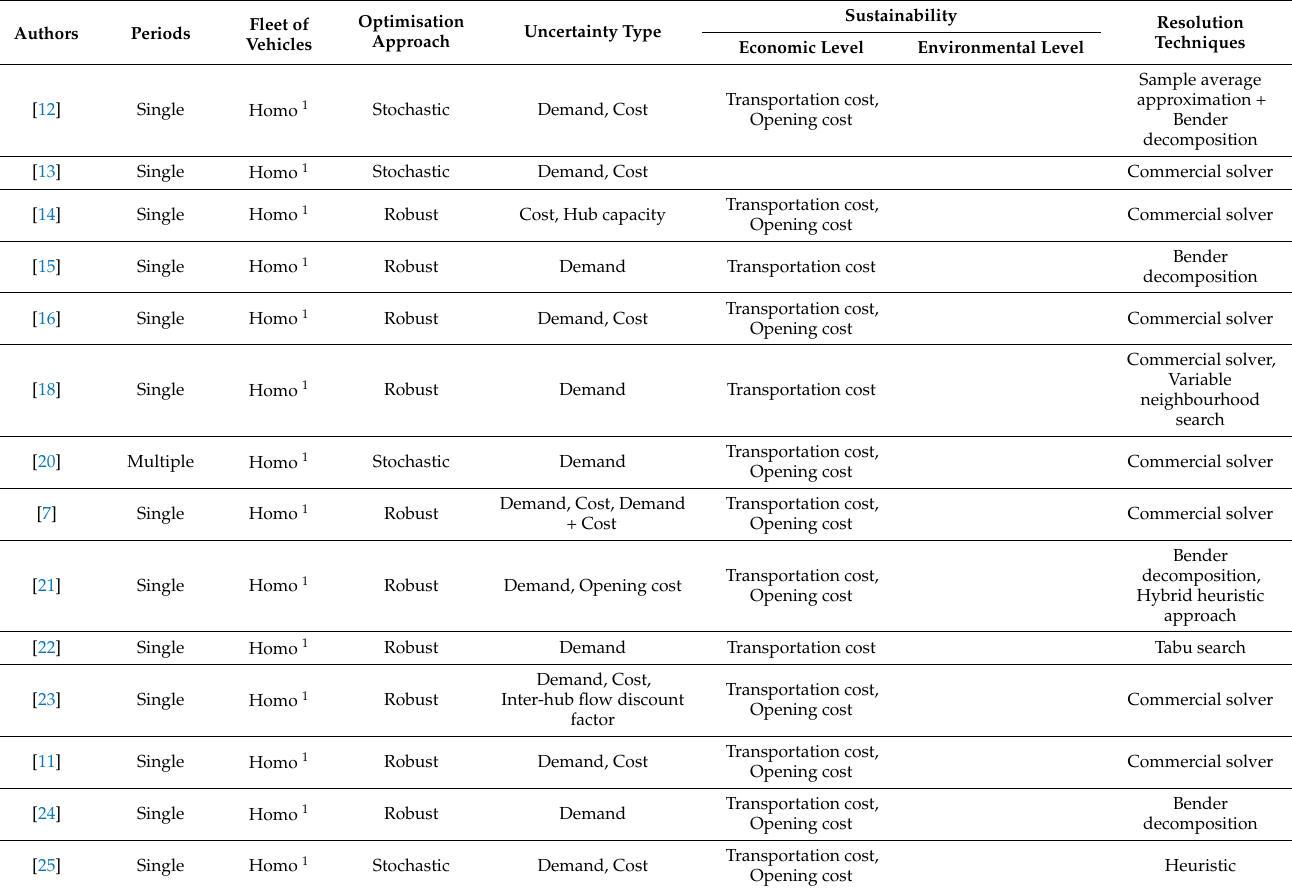
Table 1. Related